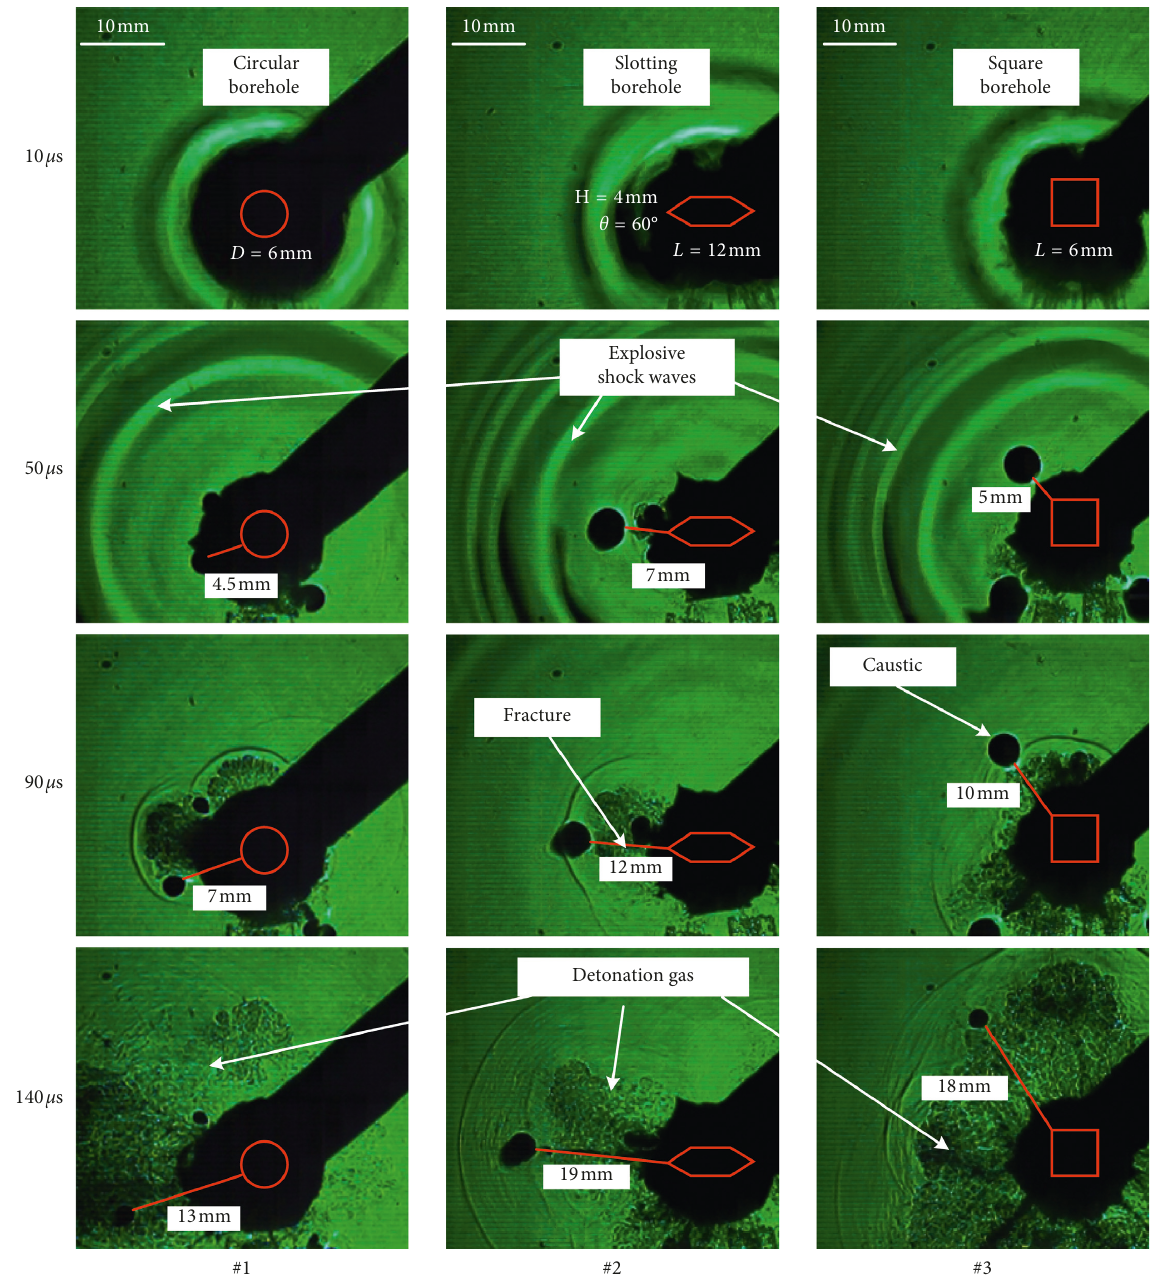
Figure 2: Propagation process of the blasting fractures. Note: caustic is a dark spot formed by stress concentration at the crack tip in a dynamic caustics experiment, which is used to indicate the position of the crack tip in this